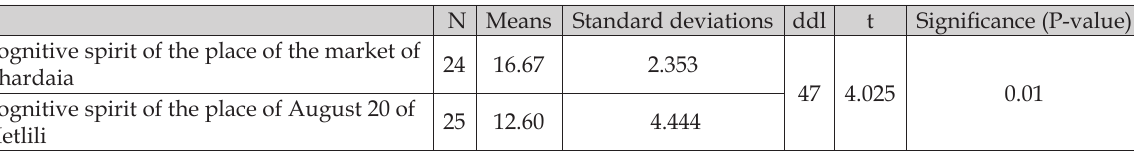
Table 8. Comparison between the means of cognitive spirits of the two public spaces.